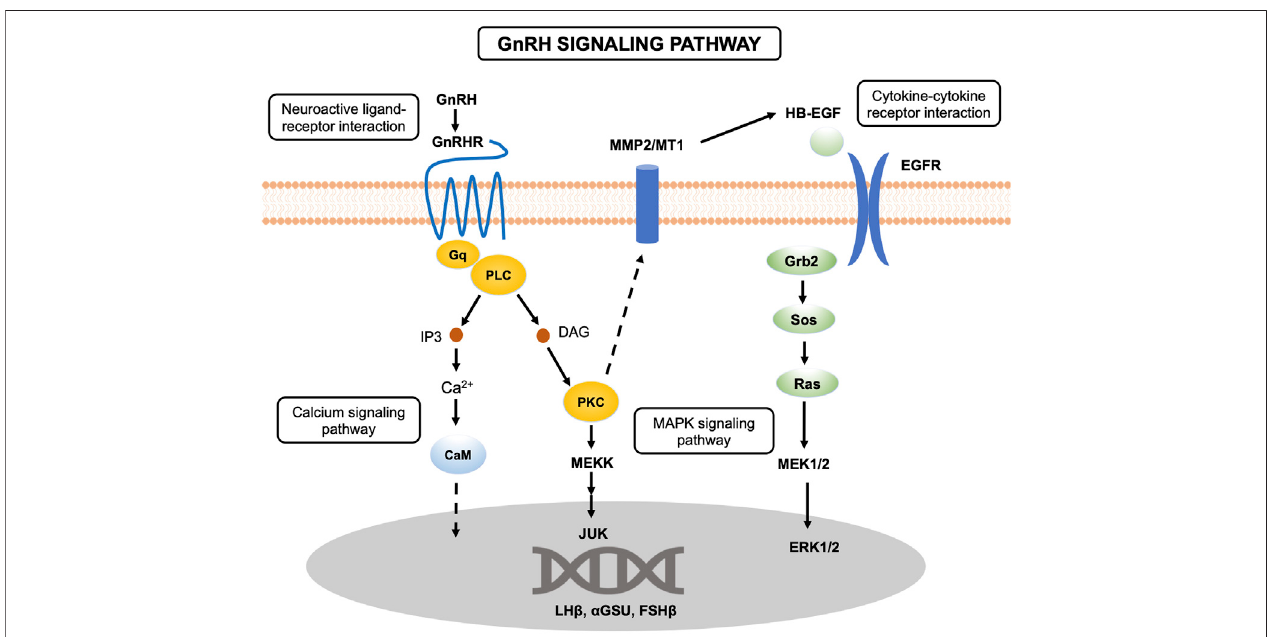
FIGURE 8 | Schematic overview of the GnRH signaling